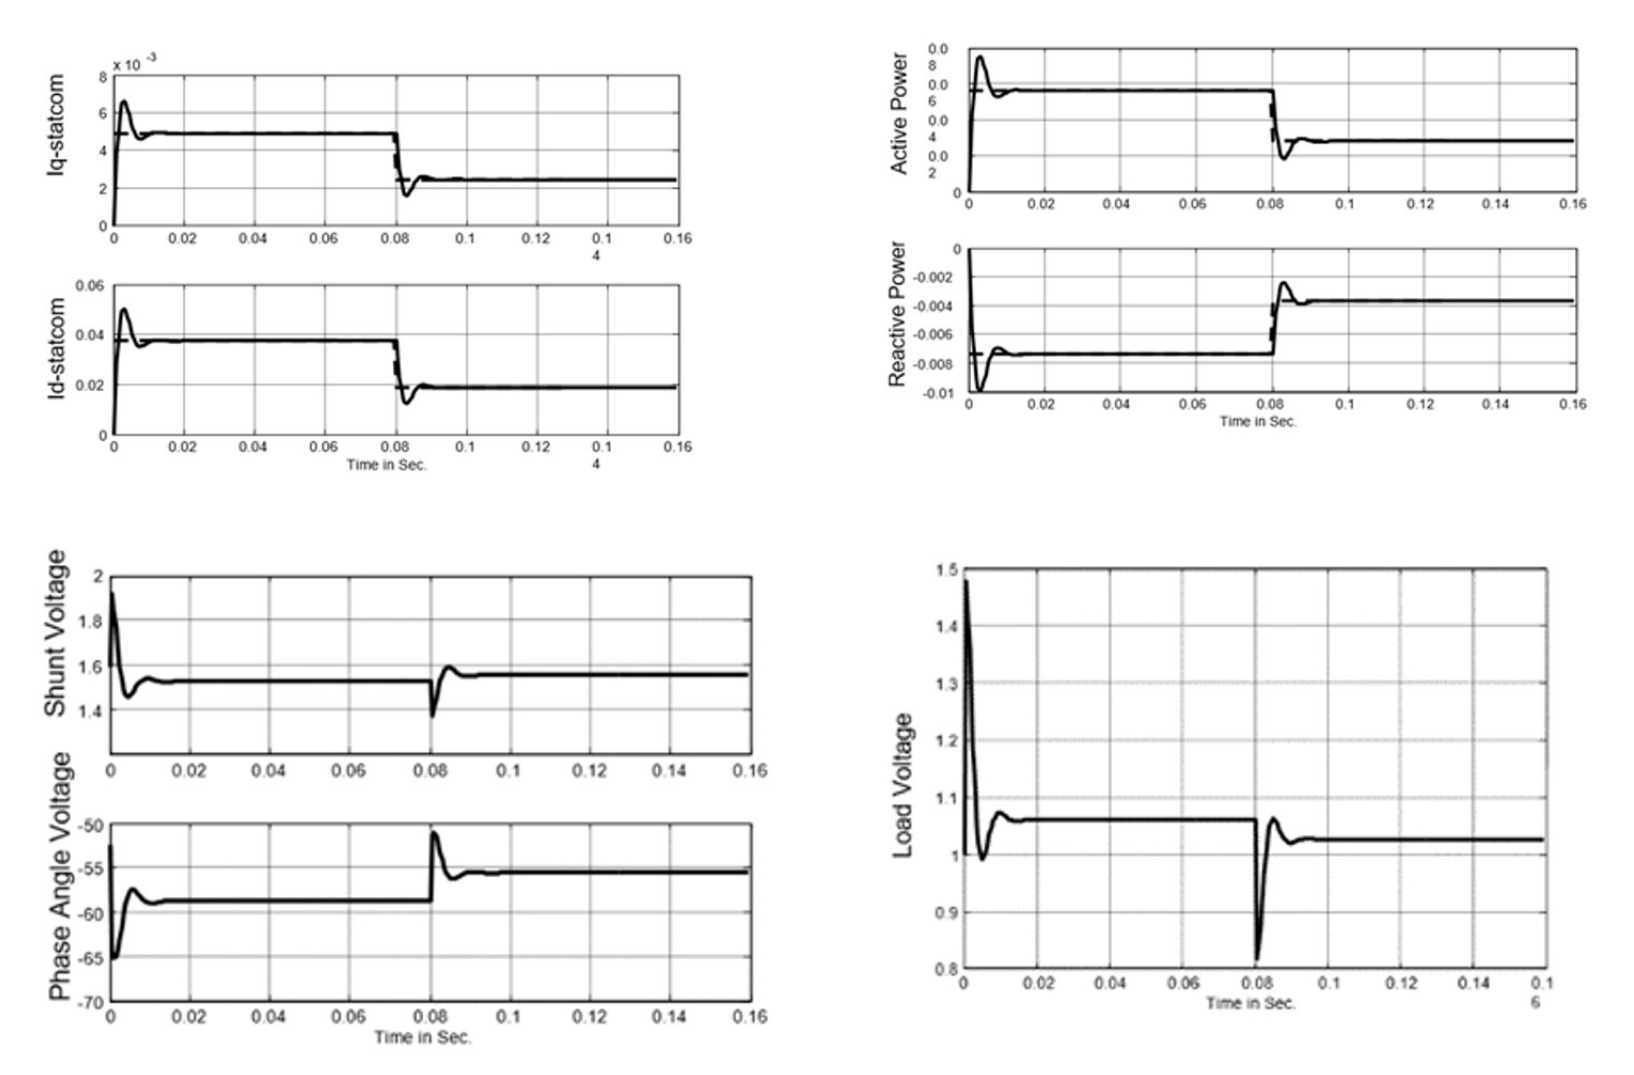
Figure 10. The transient performance of the STATCOM in case of Active and Reactive Power Variations with